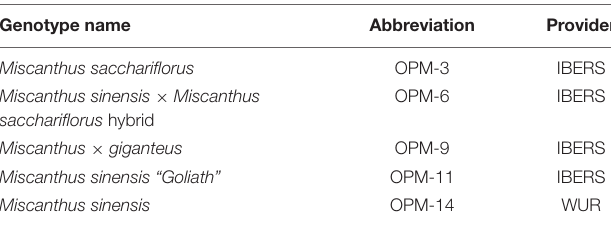
TABLE 1 | Description of miscanthus genotypes used in this study (Lewandowski et al., 2016).